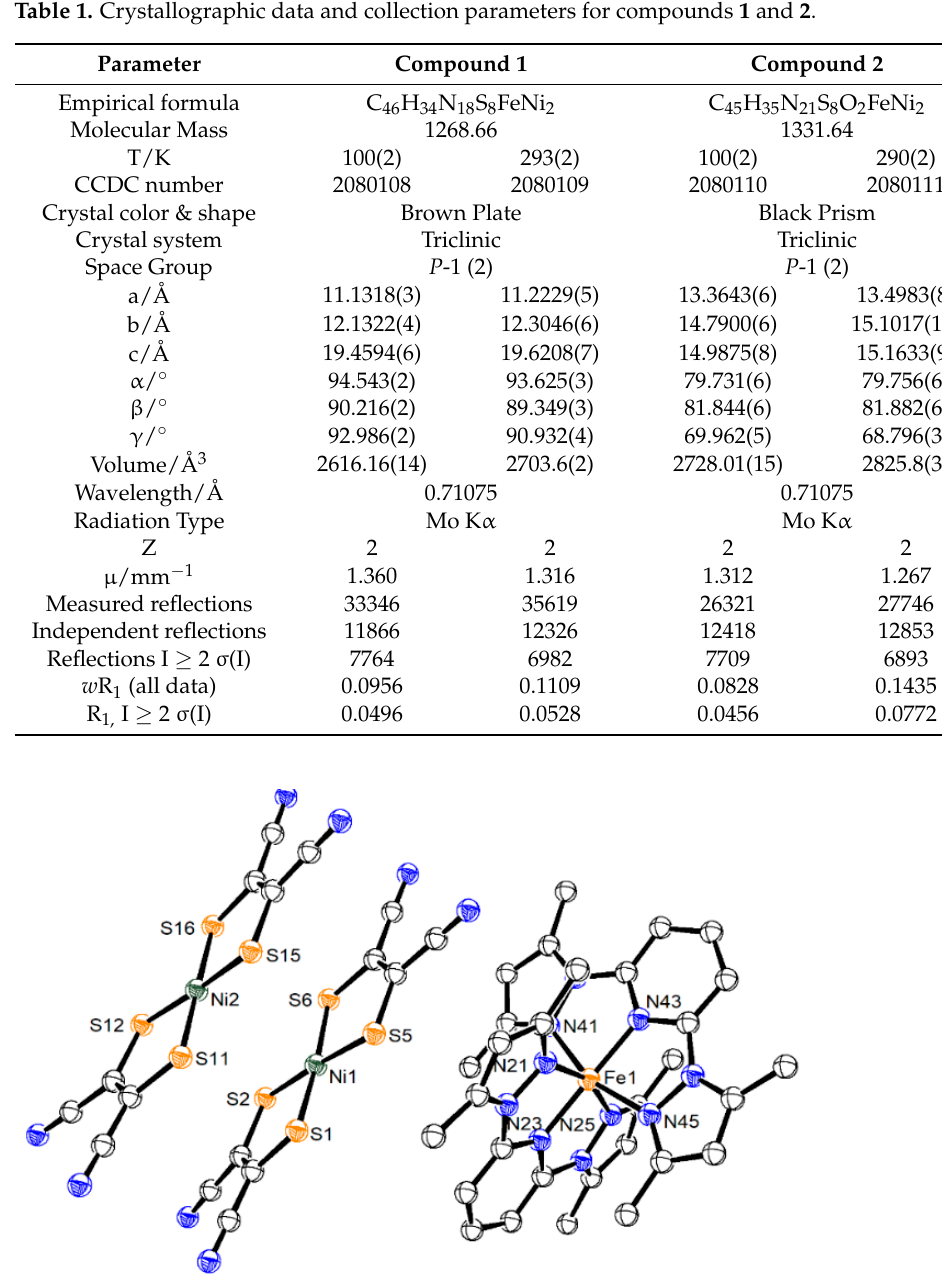
Figure 2. The molecular structure of compound 2 at 100 K, in the ORTEP [29] style with 50% ther- mal ellipsoids and atom numbering scheme. H atoms have been omitted for clarity. For compound 1, the coordination geometry about the Fe(II) cation has a distorted octahedral FeN 6 environment. From the point of view of SCO, it is important to look at the Fe-N bond lengths, which reflect the spin-state [12]. In compound 1 , at 100 K, these bond lengths range from 1.889 to 1.987 Å (average 1.957 Å). At 293 K, there is little change,